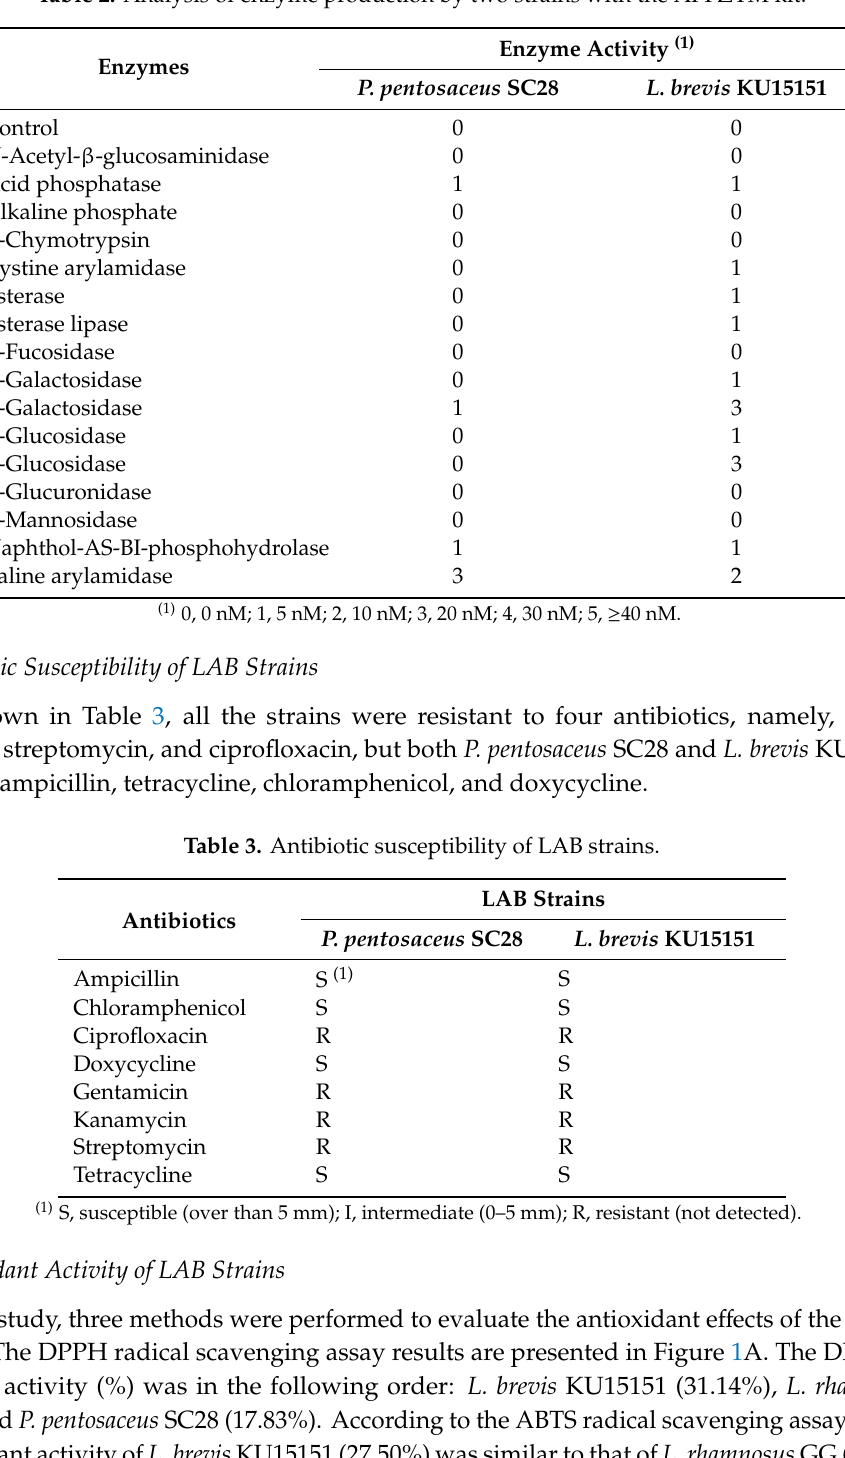
Table 2. Analysis of enzyme production by two strains with the API ZYM kit.